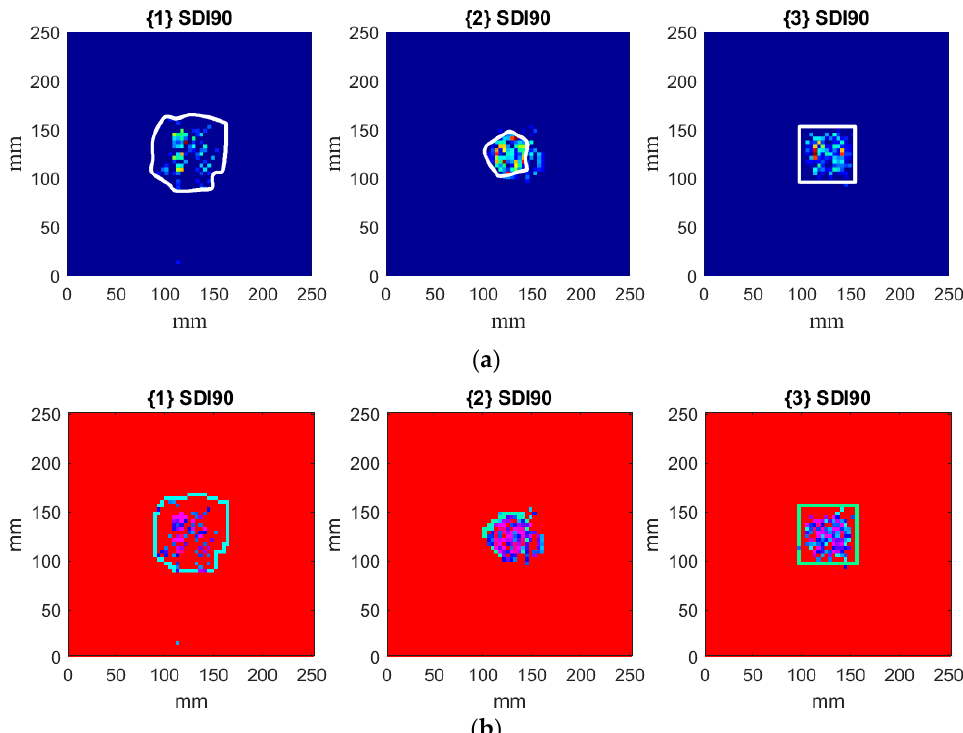
Figure 11. The results of merging of the boundaries of damage with the identified damage for the considered scenarios ( a ) and with the discretized version of the true boundaries of damage ( b ).